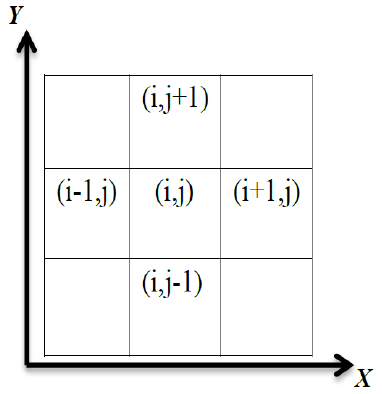
Figure 1. The Cartesian grid.